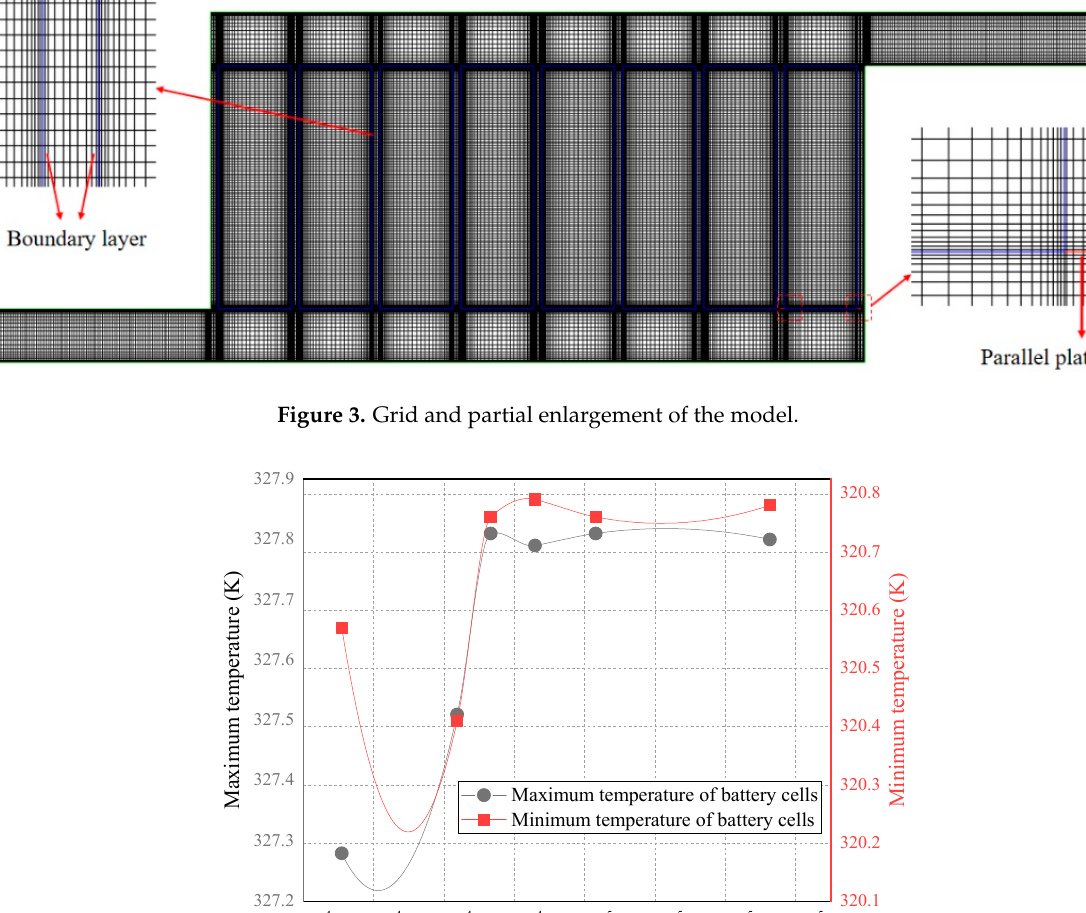
2.0x10 4 4.0x10 4 6.0x10 4 8.0x10 4 1.0x10 5 1.2x10 5 1.4x10 5 1.6x10 5